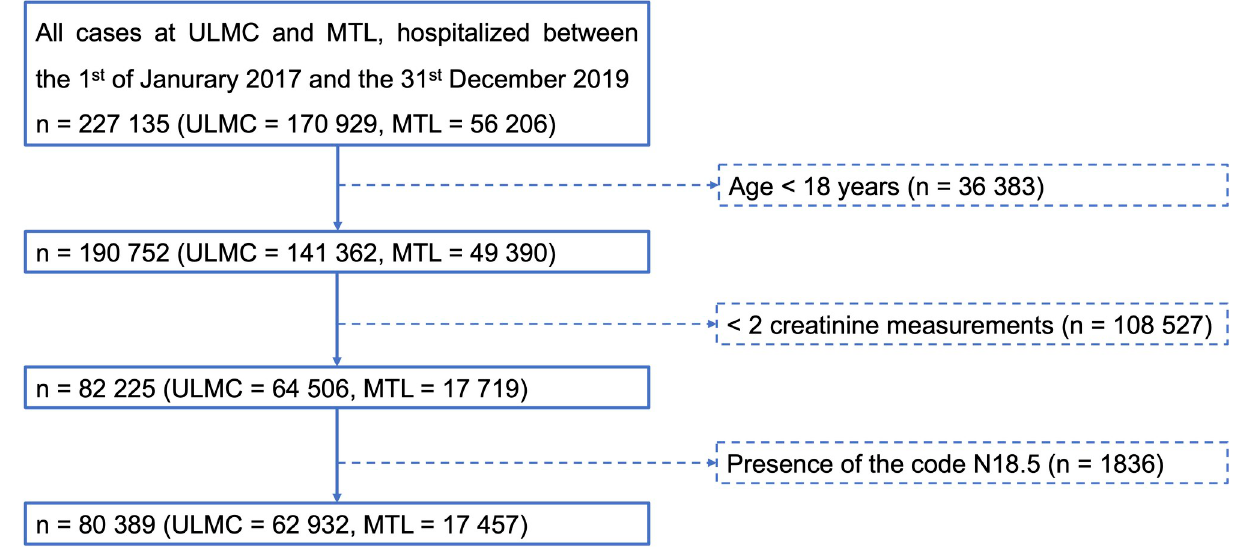
Fig 1. Study cohort with inclusion and exclusion